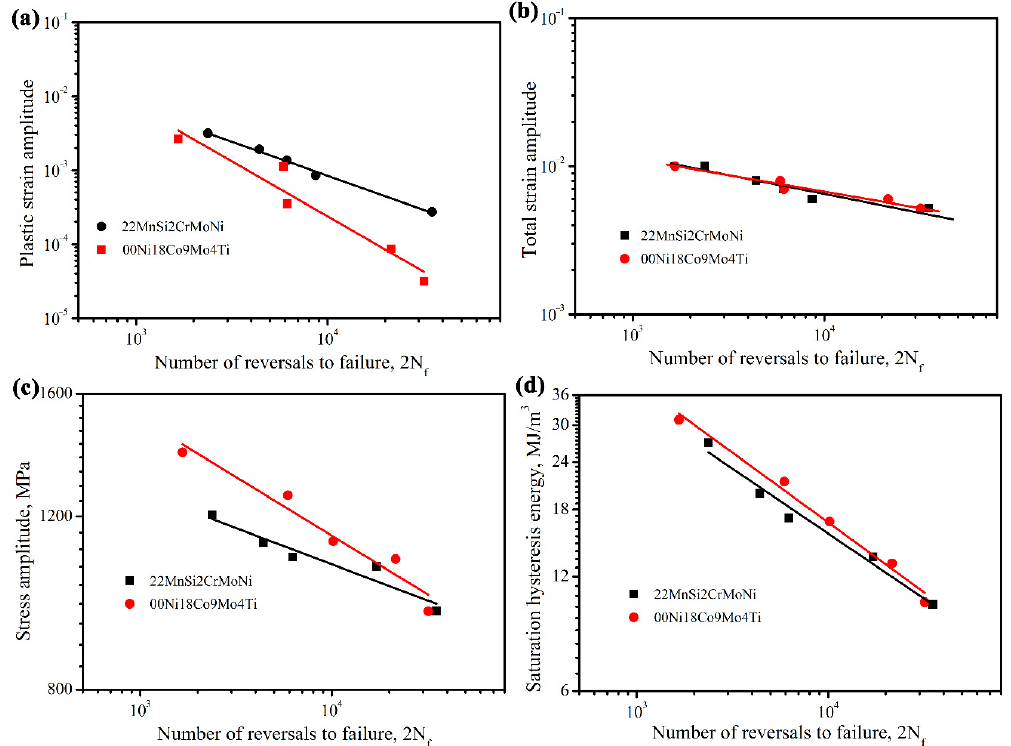
Figure 7. Curves of ( a ) plastic strain amplitude, ( b ) total strain amplitude, ( c ) stress amplitude, and ( d ) hysteresis energy versus the number of reversals to failure of 22MnSi2CrMoNi and 00Ni18Co9Mo4Ti steel.